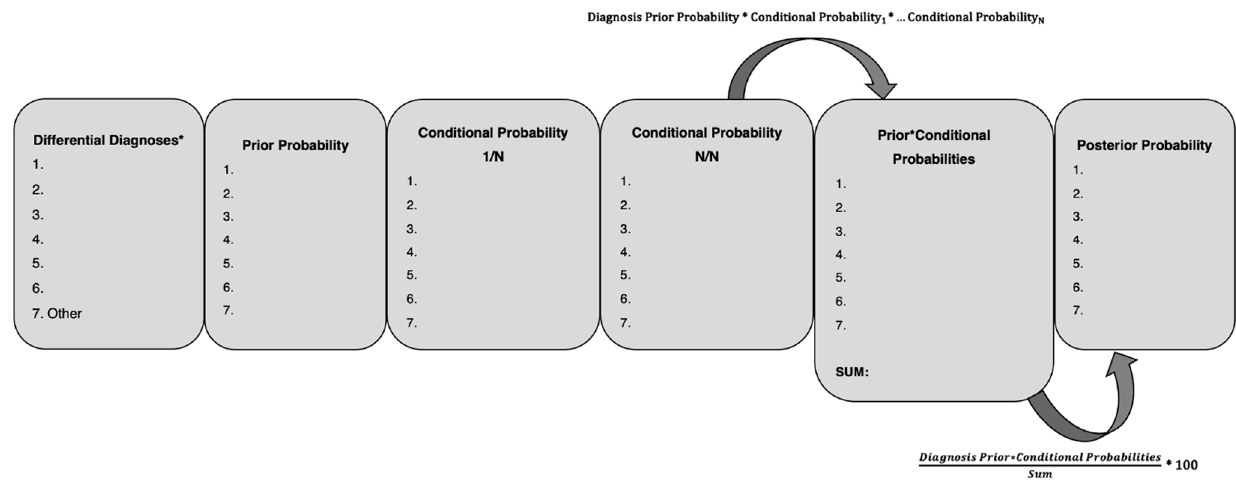
Figure 3. Template for using Bayes’ theorem to think probabilistically in diagnosis. Differential diagnoses should be exhaustive and mutually exclusive, meaning they should cover the realm of possibilities and that only one is the true primary cause of disease. If necessary, inclusion of an “other” category, consisting of aggregated low probability diagnoses, may be considered. Conditional probabilities may come from literature, expert opinion, or in the case of certain diagnostic assays, data from the manufacturer or lab. Any probability, prior or conditional, of 0 will result in that diagnosis having a posterior probability of 0, so it is important to consider whether a diagnosis or a diagnostic finding is possible, i.e., has a probability > 0, rather than simply unlikely. Posterior probability in this template is expressed as a percentage, rather than on a 0 to 1 scale. An interactive spreadsheet formulation has been included in the supplementary material (Table S4) to allow easier application of this tool.